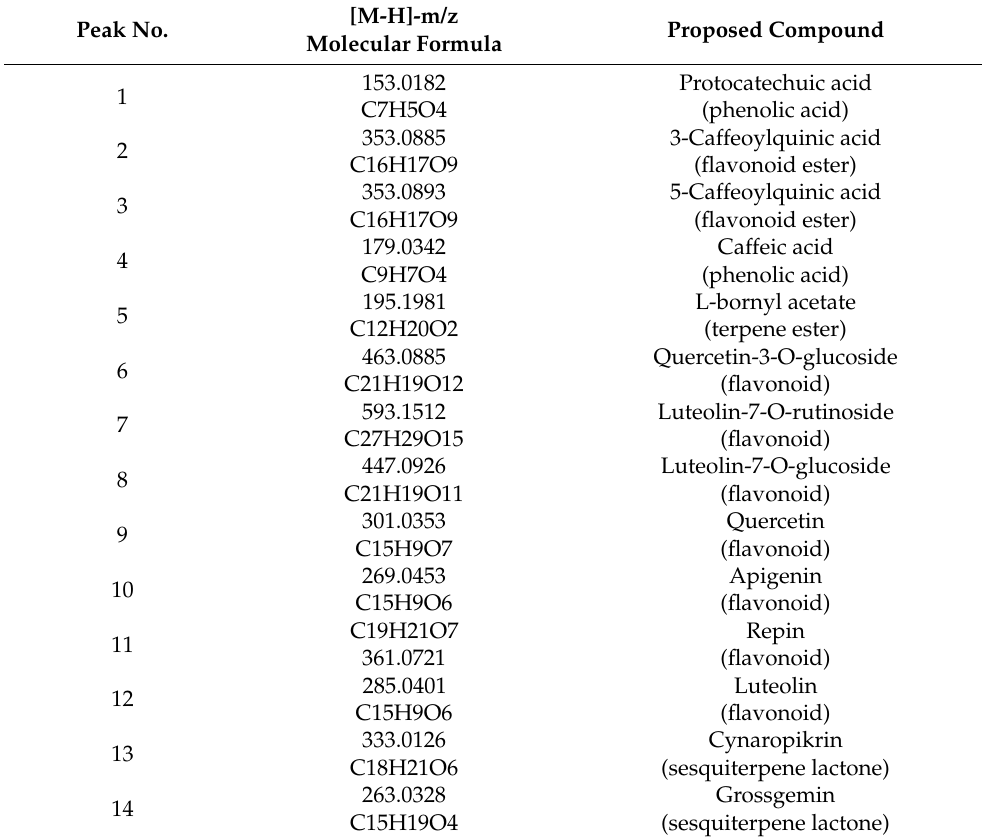
Table 3. Phytochemical composition of MTBE extracts produced from Centaurea scabiosa L. flowers. [M-H]-m/z Proposed Peak No. Molecular Formula